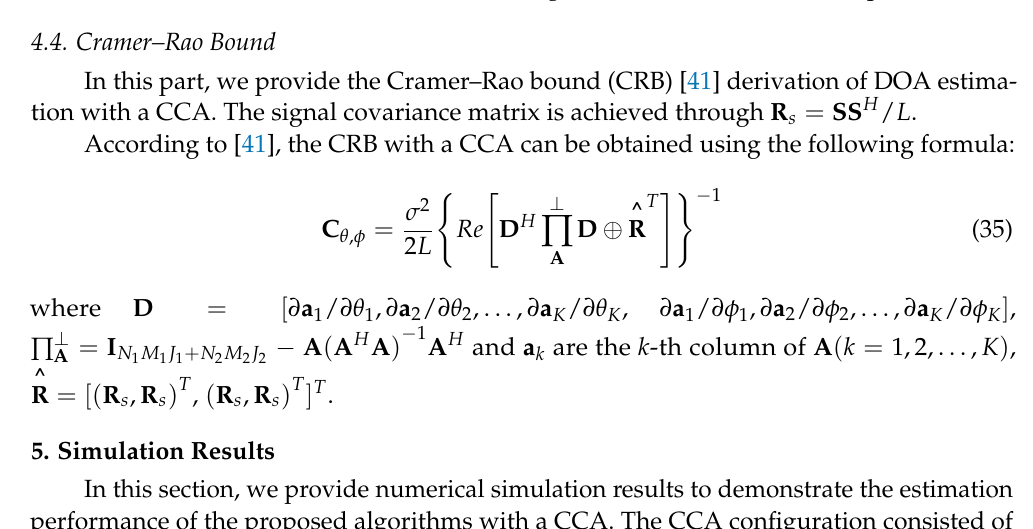
Figure 6. The scatter image of DOAs with E ‐ MUSIC. 5.1. Comparison of the DOA Estimation Performance of Different Algorithms In this subsection, we present the RMSE performance of various algorithms with a CCA, specifically, the PM [42] algorithm, the ESPRIT [43] algorithm, and the proposed TA ‐ MUSIC and E ‐ MUSIC algorithms. It is assumed that there are two DOAs from the directions of